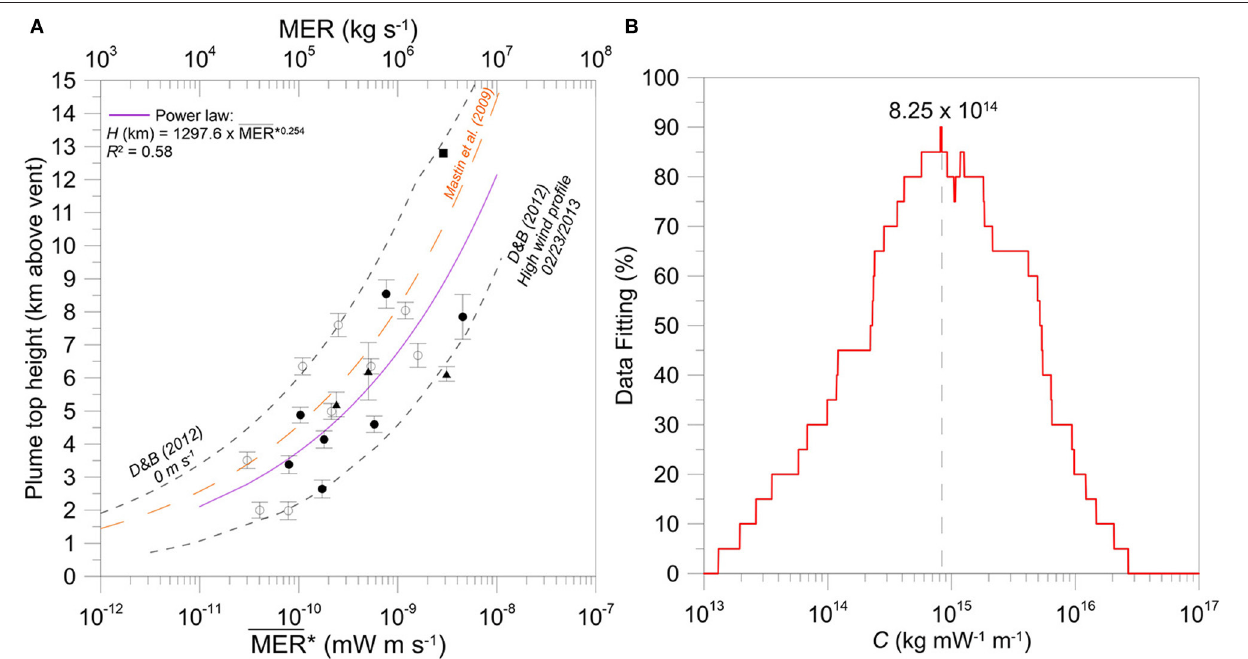
FIGURE 7 | (A) Radar Mass Eruption Rate proxies (MER*, bottom scale) and plume top heights observed between 2011 and 2013 at Etna before (open symbols) and after (filled symbols) the rotation of the antenna. Radar MER (upper scale in kg/s) are calibrated from models of Mastin et al. (2009, bold orange dashed curve)